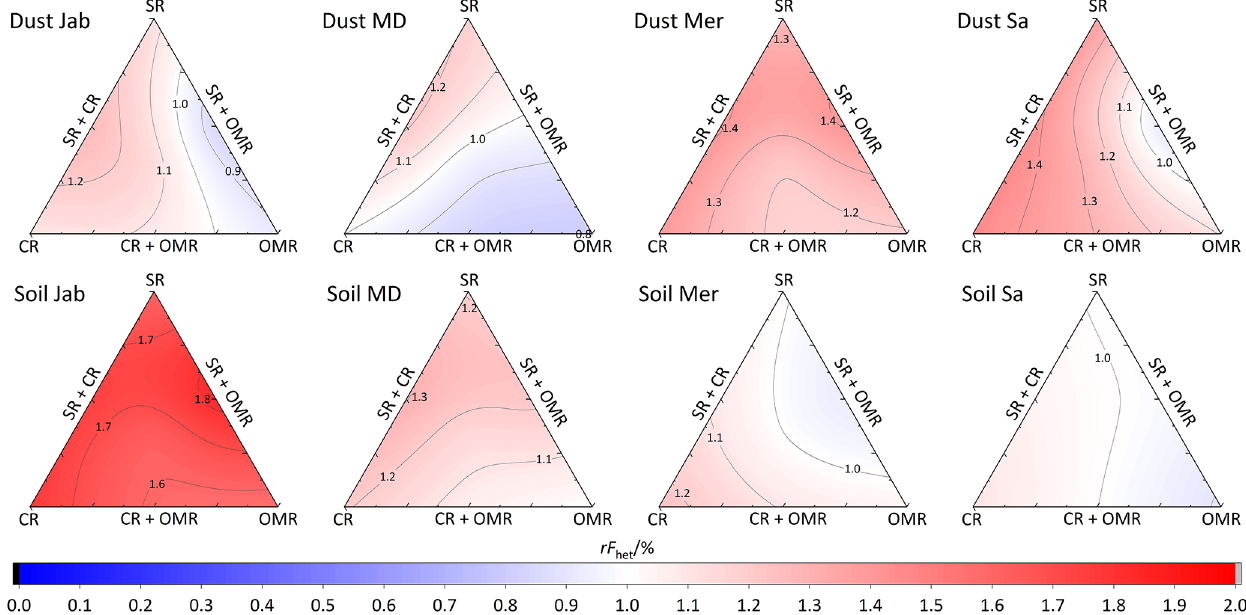
Figure A3. Effects of treatments in terms of rF het(treatment-natural) for dust and soil samples at 2wt% concentration. SR: salt removed; CR: carbonate removed; OMR: organic matter removed; SR + CR: salt and carbonate removed; SR + OMR: salt and organic matter removed; SR + CR + OMR: salt-, carbonate-, and organic-removed